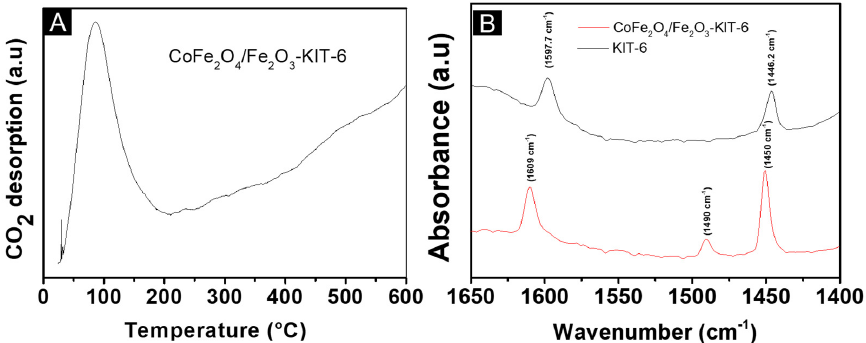
Figure 5. The acid-base properties of CoFe 2 O 4 /Fe 2 O 3 -KIT-6: ( A ) CO 2 temperature-programmed desorption (TPD-CO 2 ); ( B ) infrared with pyridine adsorption (FTIR-Py).